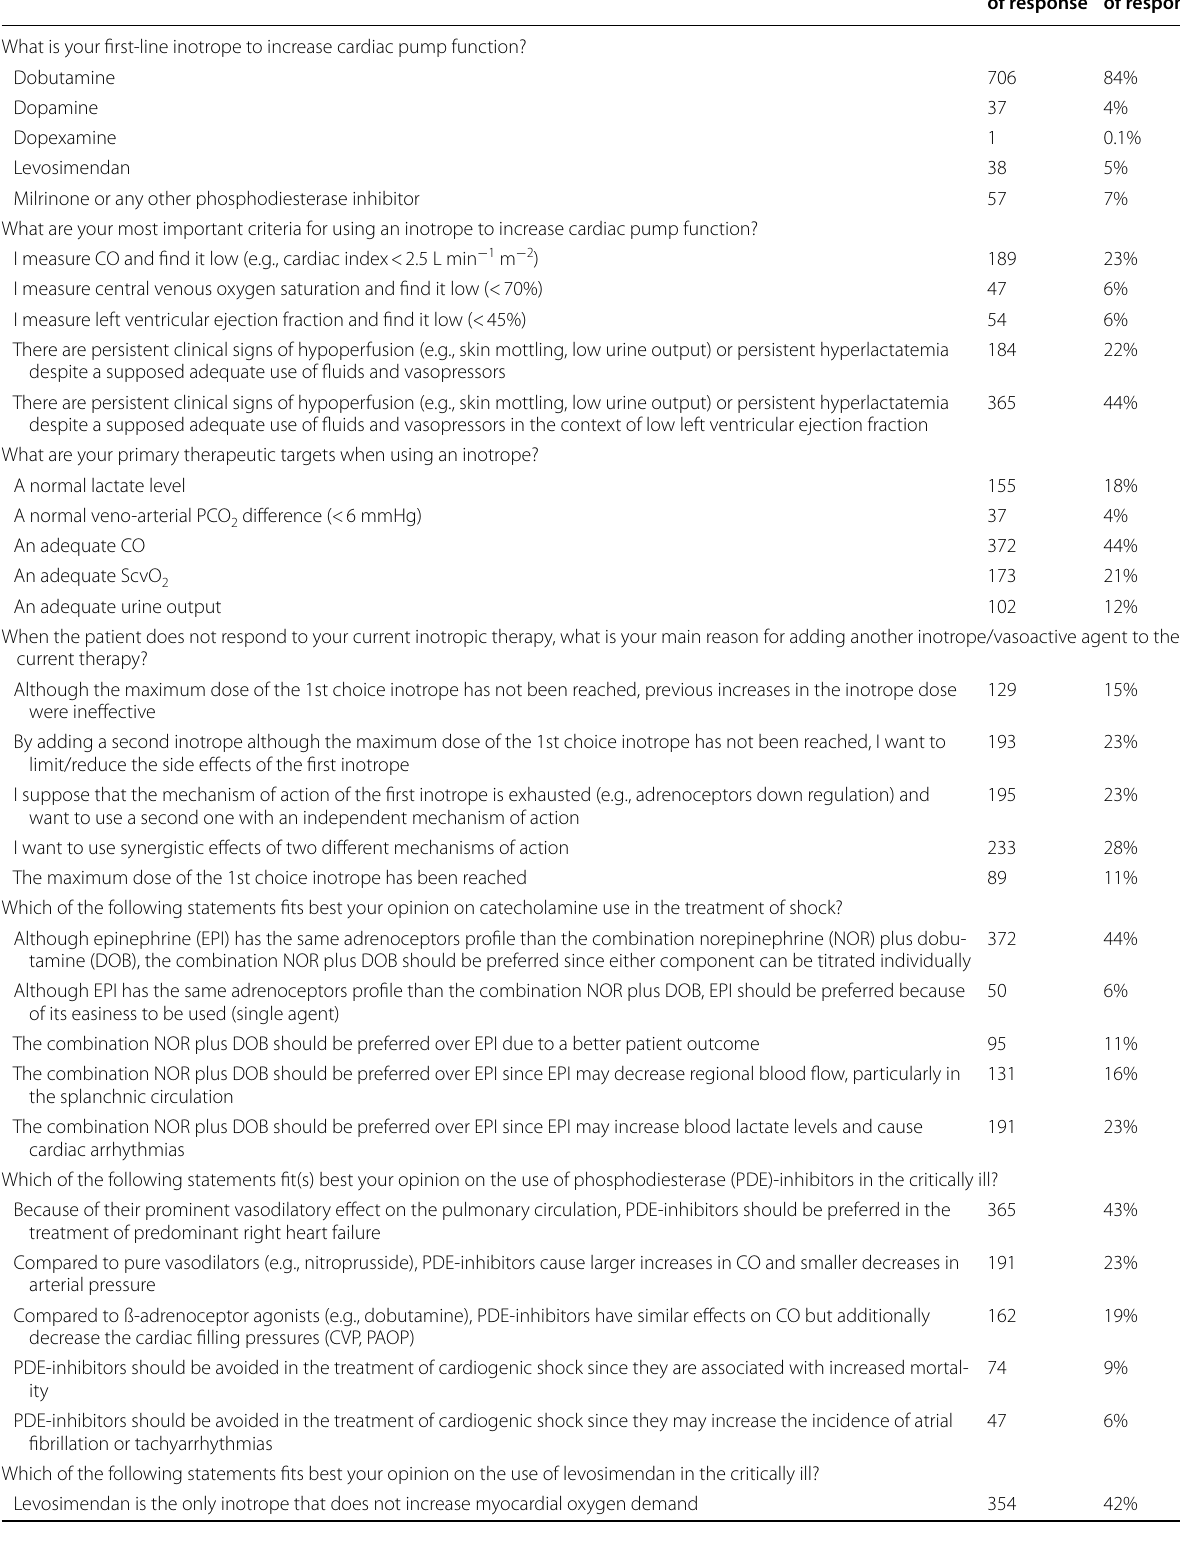
Frequency Percentage of response of